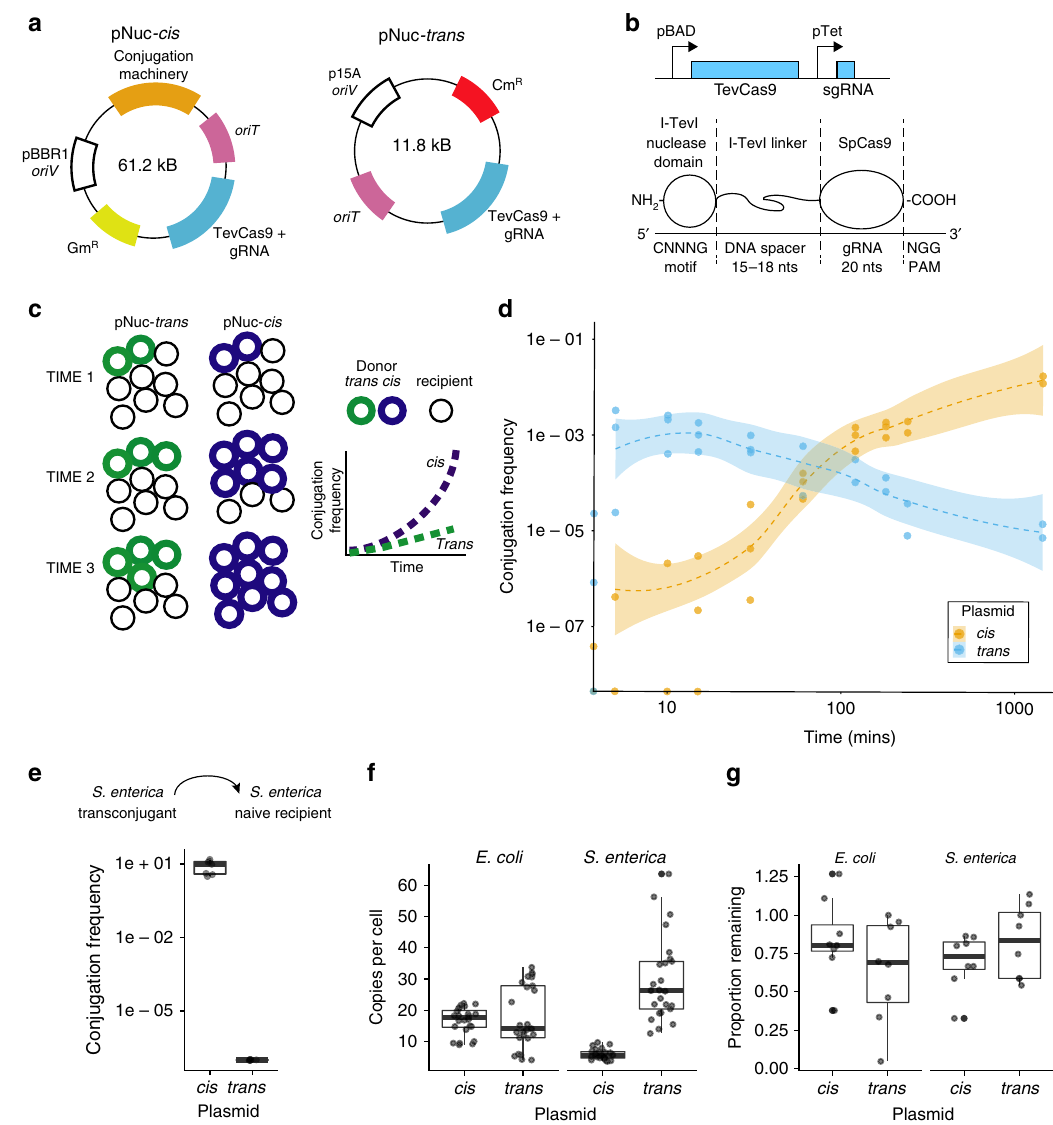
Fig. 1 Impact of cis or trans localization of conjugative machinery on conjugation frequency. a Schematic view of the pNuc- cis and pNuc- trans plasmids. oriT conjugative origin of transfer, oriV vegetative plasmid origin, Gm R gentamicin resistance gene, Cm R chloramphenicol resistance gene, TevSpCas9/sgRNA coding region for TevSpCas9 nuclease gene and sgRNA. Conjugative machinery, genes required for conjugation derived from the IncP RK2 conjugative system. b (Top) The TevSpCas9 and sgRNA cassette (not to scale) highlighting the arabinose regulated pBAD and constitutive pTet promoters. (Below) The modular TevSpCas9 protein and DNA binding site. Interactions of the functional TevSpCas9 domains with the corresponding region of substrate are indicated. c Model of pNuc spread after conjugation with the cis and trans setups. Cell growth overtime will account for increase of pNuc- trans . d Filter mating assays performed over 24 h demonstrate that pNuc- cis has a higher conjugation frequency than pNuc- trans . Points represent independent experimental replicates, and the 95% con fi dence intervals are indicated as the shaded areas. Conjugation frequency is reported as the number of transconjugants (Gm R , Kan R ) per total recipient S . enterica cells (Kan R ). e Conjugation frequency of S . enterica transconjugants harboring either pNuc- cis or pNuc- trans to naive S . enterica recipients. Data are shown as boxplots with points representing individual replicate experiments. f pNuc- cis and pNuc- trans copy number determined by quantitative PCR in either E . coli or S . enterica . Data are shown as boxplots with solid lines indicating the median of the data, the rectangle the interquartile bounds, and the wiskers the range of the data. Points are individual experiments. g pNuc- cis and pNuc- trans stability in E . coli or S . enterica determined as the ratio of cells harboring the plasmid after 24 h growth without antibiotic selection over total cells. Data are shown as boxplots with dots indicating independent experiments. Source data are provided as a Source Data fi